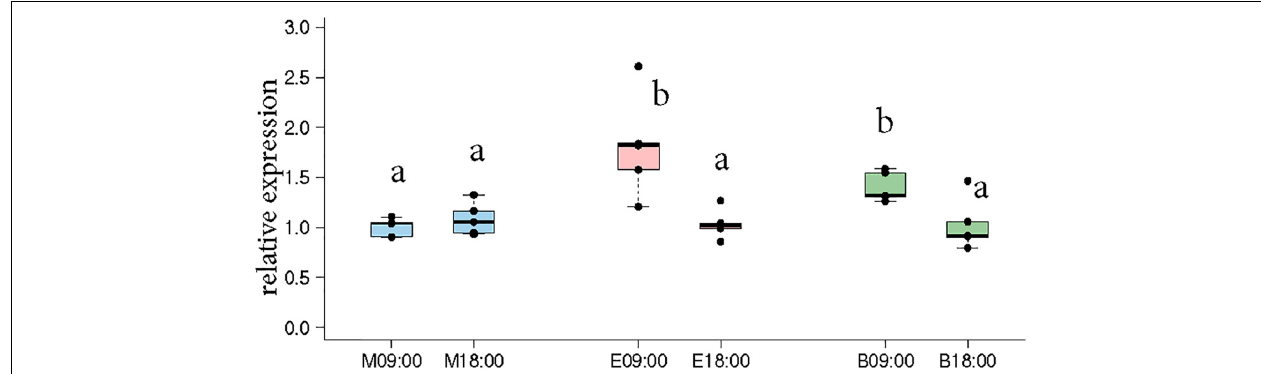
FIGURE 3 | Cry-2 expression comparison between morning time-point (09:00) and evening time-point (18:00) in the same bees as shown in Figures 2C,D . “Morning only” (M09:00, M18:00; blue) bees showed no significant differences in Cry-2 expression whereas “evening only” (E09:00, E18:00; red) bees showed significantly higher expression in the morning compared to evening. “Both feeder” (B09:00, B18:00; green) bees showed significantly higher expression in the morning compared to evening, similar to “evening only” bees. The lower expression value in all 3 groups were not significantly different from each other. Data shown as relative expression changes compared to the lowest value in the form of box-plots with individual data-points delineated. KW-test with Dunn’s (“bh” method) multiple comparison was done on the entire data-set, p -values are shown in Supplementary Tables S4, S5, respectively.